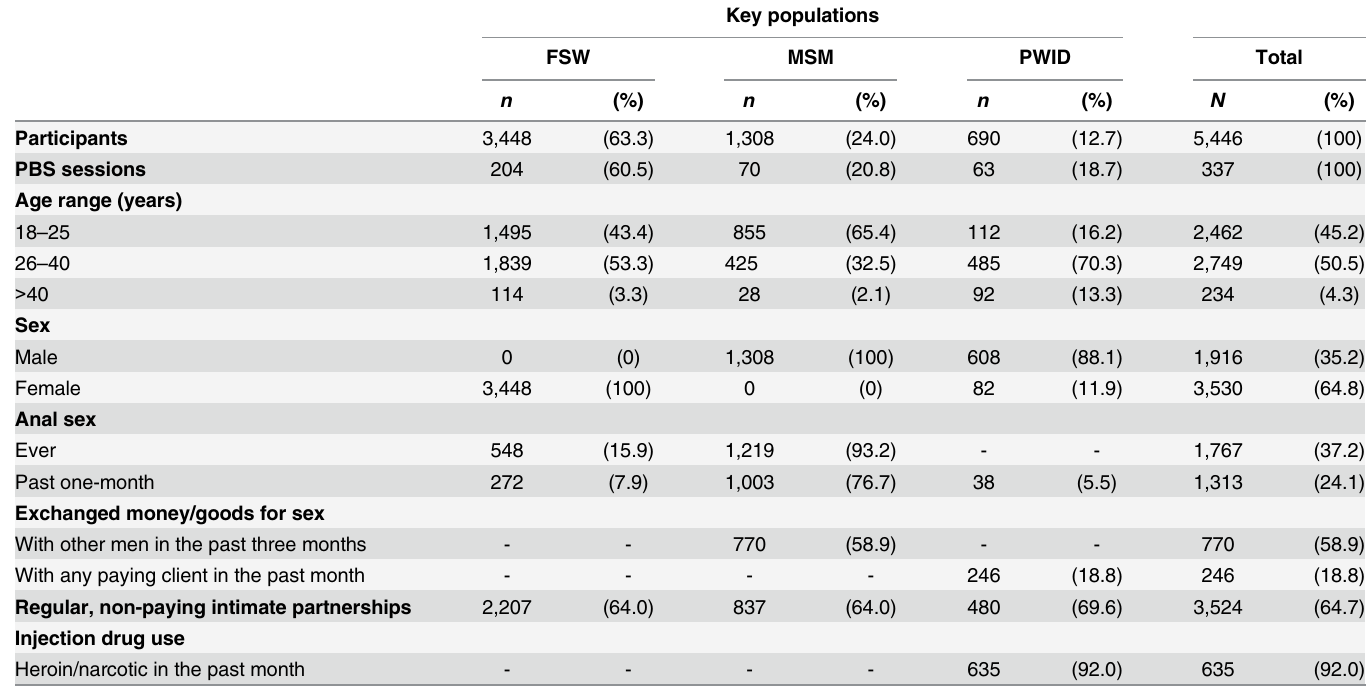
Table 2. Sociodemographic characteristics and self-reported HIV risk behaviours of polling booth survey